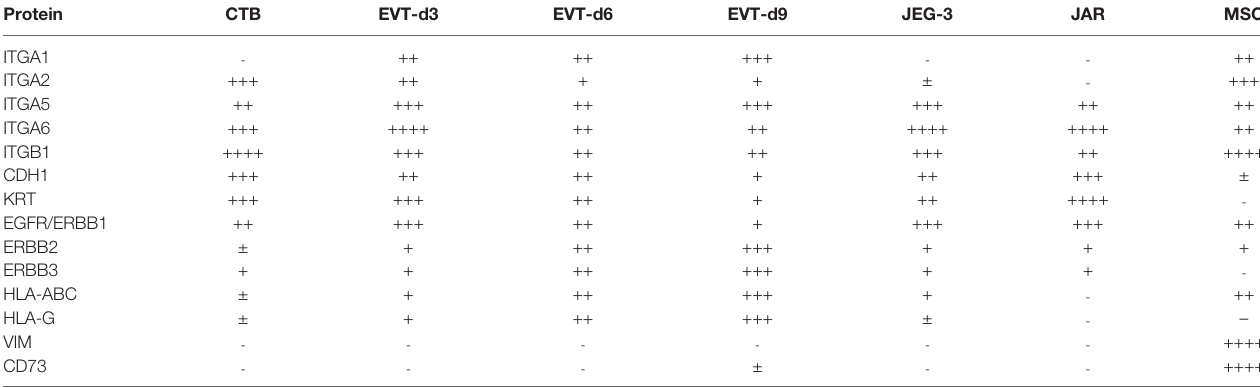
TABLE 4 | Surface markers on various cell cultures 1 . EVT-d3 EVT-d6 EVT-d9 JEG-3 JAR